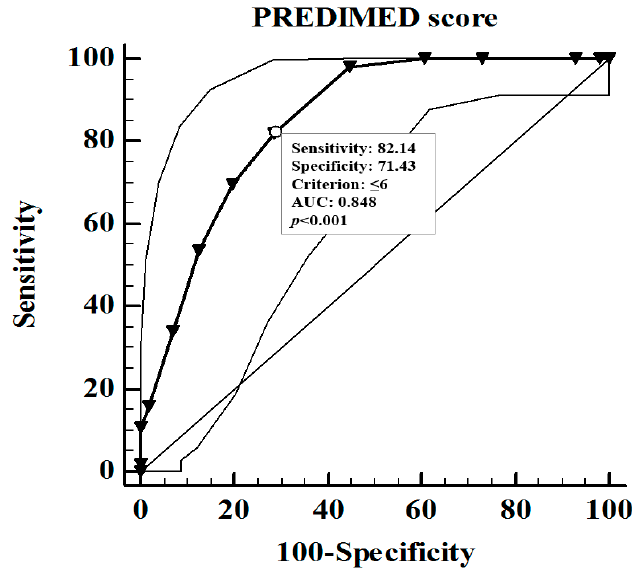
Figure 2. The ROC analysis was performed to determine the cut off values of the PREDIMED score that was predictive of highest values of testosterone levels (above the median value 22.27 ng/dL). A value of PREDIMED score of ≤ 6 ( p <0.001, AUC 0.848, standard error 0.036, 95% CI 0.768 to 0.909) could serve as a threshold for a significantly increased risk of high value of testosterone levels. PREDIMED, PREvenci ó n con DIetaMEDiterr á nea; ROC, Receiver operator characteristic; AUC, area under the curve; CI, confidence